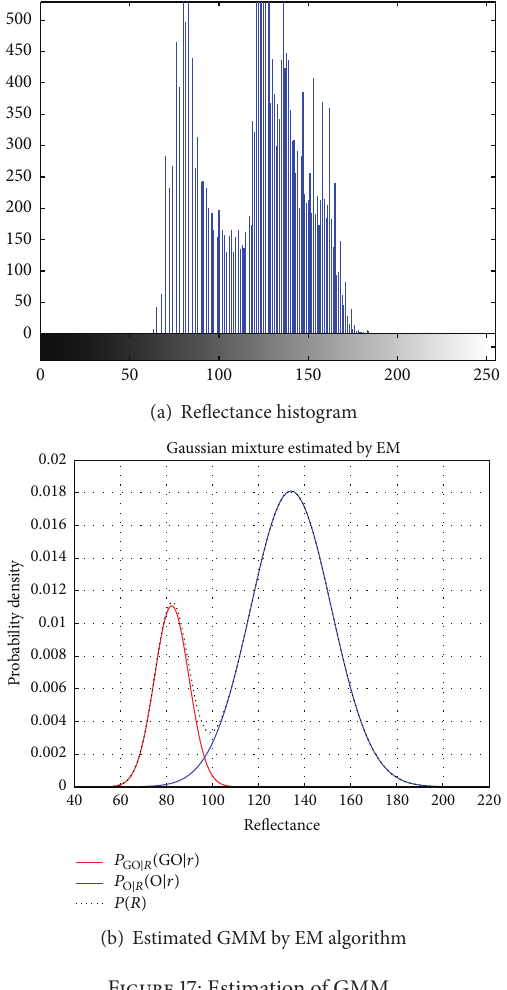
Figure 17: Estimation of